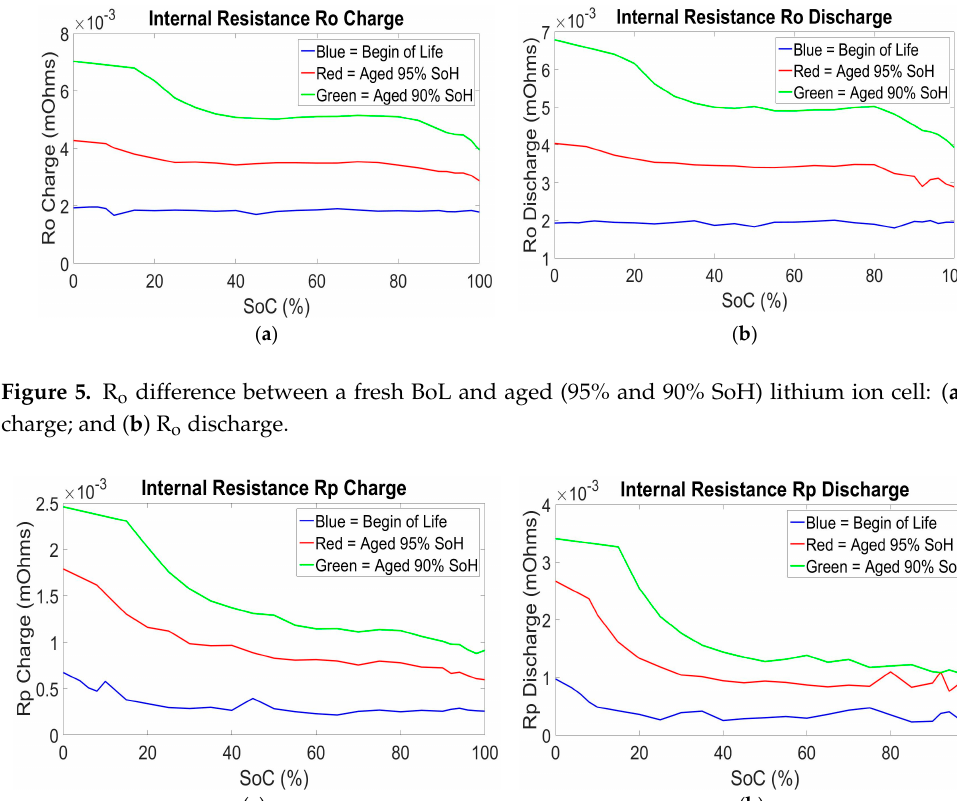
Figure 6. Activation R p difference between a fresh BoL and aged (95% and 90% SoH) lithium ion cell: ( a ) R p charge; and ( b ) R p discharge.